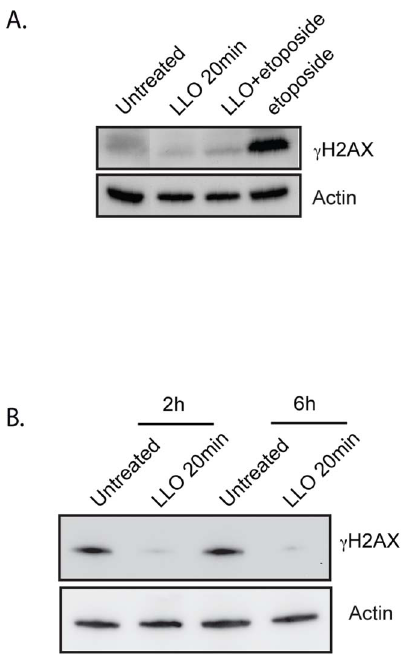
Figure 3. LLO dampens the DDR. (A) and (B) Immunoblots of HeLa cells treated with LLO or left untreated. Toxin treatment was performed for 20 minutes and removed prior to treatment with etoposide (A) or prior to X-irradiation (B). Cells were irradiated with 10 Gray and harvested either 2 h or 6 h after irradiation. Images are representative of experiments performed at least 3